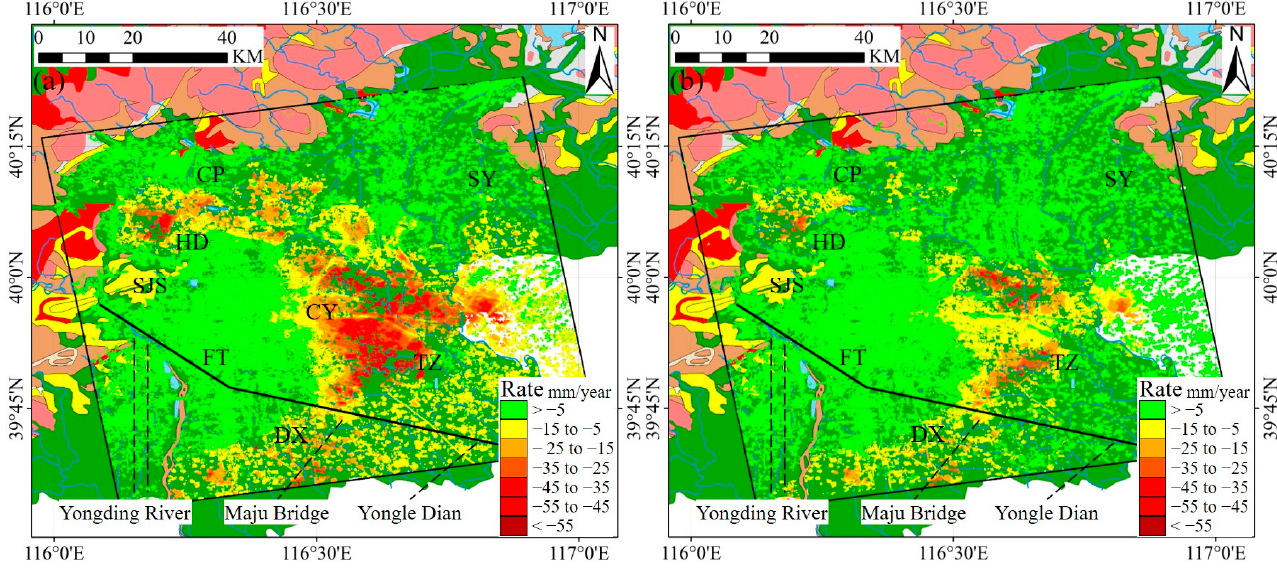
Figure 13. ( a ). Surface subsidence rate from January 2018 to March 2020 and geological horizontal distribution. ( b ). Surface subsidence rate from February 2020 to April 2022 and geological horizontal distribution.